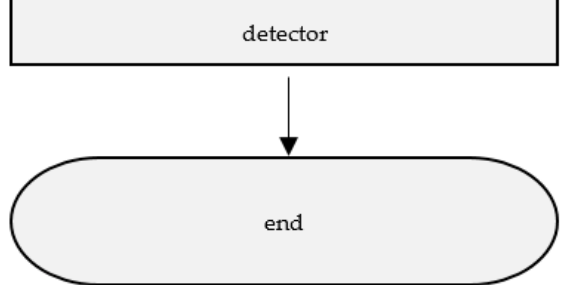
Figure 2. KCF’s implementation of the scale adaptation process. IOU: intersection over union. The pedestrian detection framework we use is YOLOv3. YOLOv3 is a neural network with darknet-53 as a backbone network to extract the characteristics of an image. Because the receptive field of each layer in the network is different, YOLOv3 extract targets of different scales in different layers; a total of three scales were identified, and the MS-COCO (Microsoft Common Objects in Context) dataset [9] was used to train the network. For the smallest detection scale, YOLOv3 divides the image into 52 × 52 grids because the 52 × 52 size is suitable for commonly seen small-scale objects and each grid is used as an anchor point. The input image for YOLOv3 is compressed to a fixed size, so the grid size is independent from the input image. Three bounding boxes of different shapes are identified at the anchor point. For the middle scale, the model divides the image into 26 × 26 grids as anchor points, because the grid size of 26 × 26 is suitable for commonly seen middle-scale objects. For the largest scale, the model divides the image into 13 × 13 grids as anchor points because the grid size of 13 × 13 is suitable for commonly seen large-scale objects.